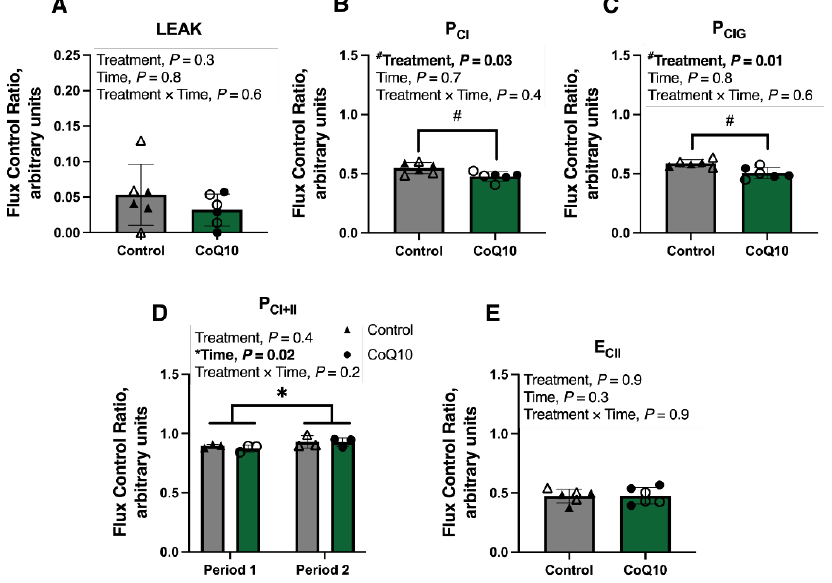
Figure 4. ( A – E ) Flux control ratios (FCR) of gluteus medius samples from fit Thoroughbred horses before and after 30 d supplementation of CoQ10 or control diet. Open circles represent horses on the CoQ10 supplement during the first supplementation period, and closed circles represent horses on the CoQ10 supplement during the second supplementation period. Open triangles represent horses on the control diet during the second supplementation period, and closed triangles represent horses on the control diet during the first supplementation period. # Regardless of time (period), control differs from CoQ10 ( p ≤ 0.05). *Across treatments, period 1 differs from period 2 ( p ≤ 0.05).